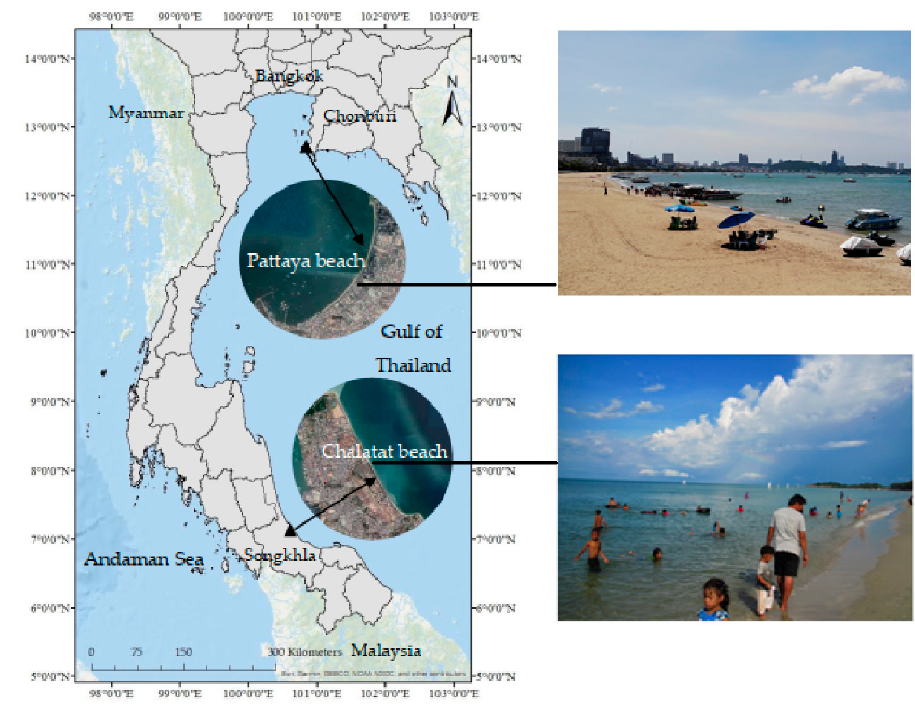
Figure 1. Study areas map.